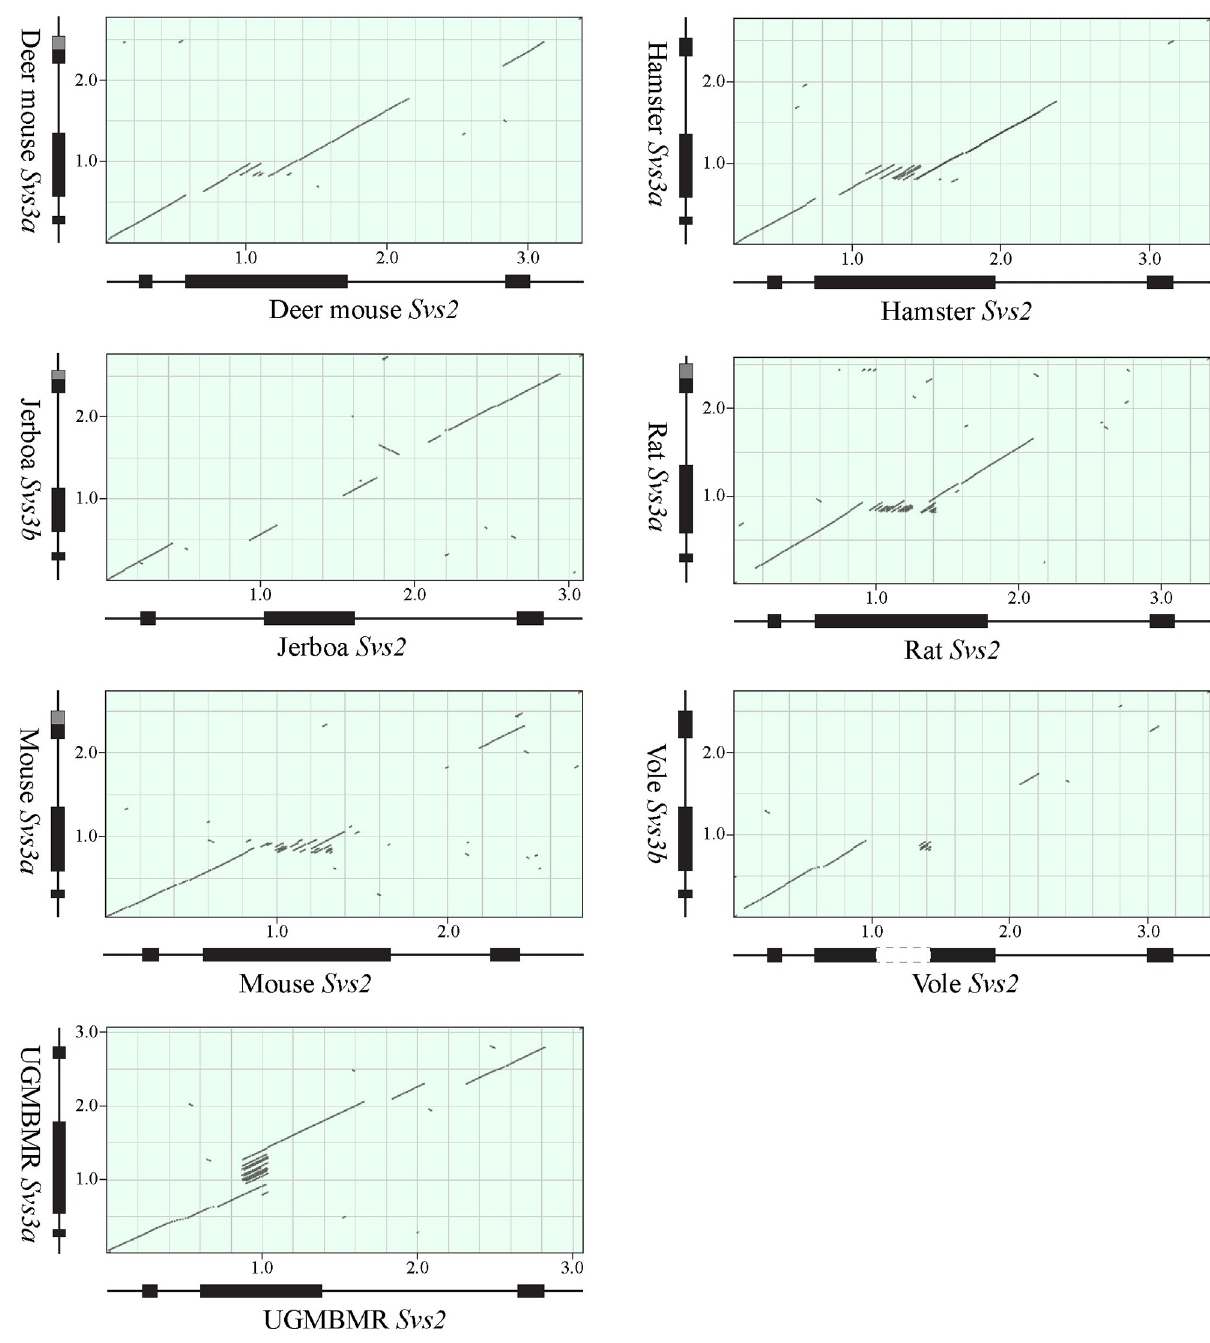
Fig 9. Homology of Svs2 and Svs3 in myomorph rodents. Dotplots were generated by aligning sequences with the computor program BLAST. The drawings diplayed under and to the right of the dotplots are scematic illustrations of the genes with exons shown as boxes. A gap in the genomic sequence of vole Svs2 is painted white. The dark grey parts in exon 3 of Svs3 depict that there are alternative poly-adenylation sites within the displayed gene or that Svs3a and Svs3b have different poly-adenylation sites. The numbers on the axis show distance in kb from the beginning of the aligned sequences. Note the tandem repeats in the central part of exon 2 in deer mouse, hamster, rat, and muse Svs2 , as well as the equally positioned repeats in UGMBMR Svs3 .